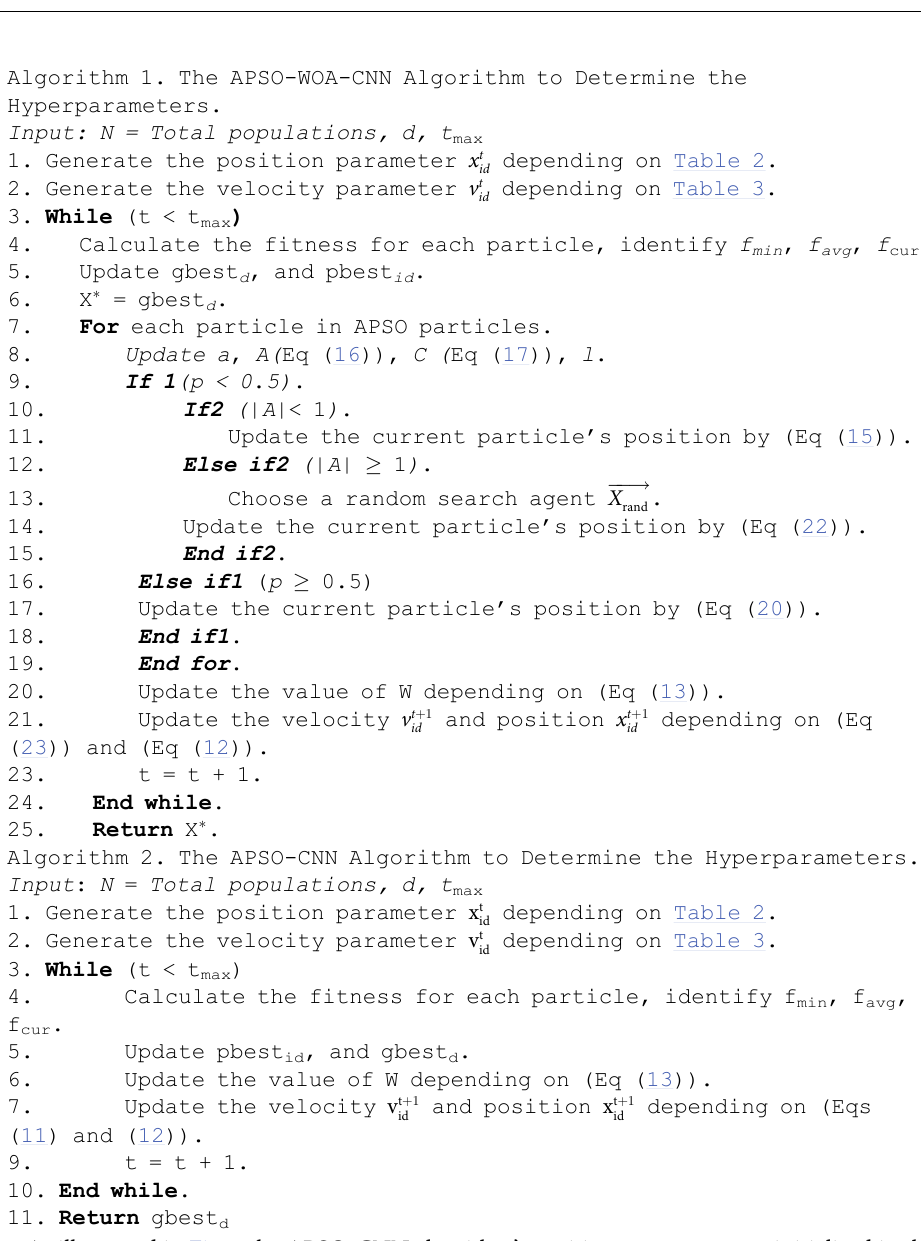
Algorithm 1. The APSO-WOA-CNN Algorithm to Determine the Hyperparameters.